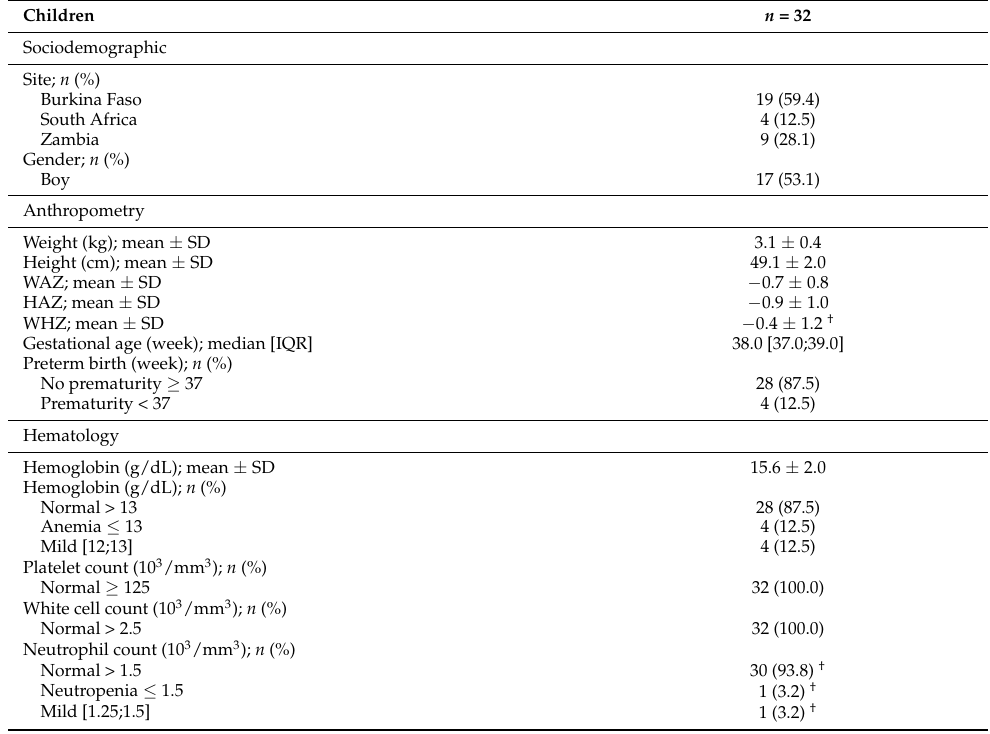
Table 1. Characteristics of the mother–child pair at day seven post-partum.